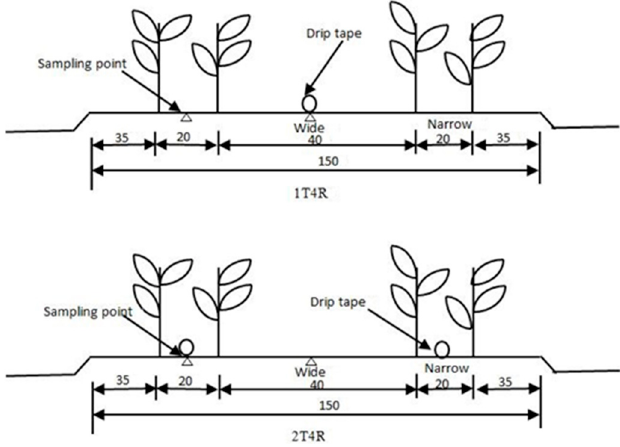
Figure 2. Schematic diagram of cotton planting method and drip irrigation belt layout (cm).